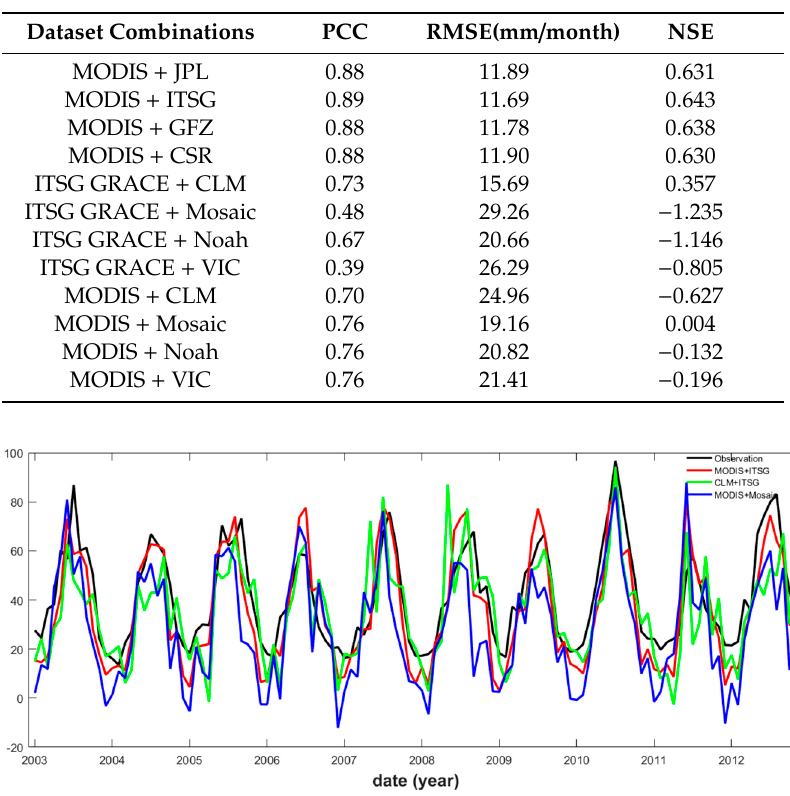
Figure 7. Remotely sensed runoff for the Yangtze river basin derived from the MODIS Figure7. Remotelysensedruno ff fortheYangtzeriverbasinderivedfromtheMODISevapotranspiration evapotranspiration and ITSG GRACE terrestrial water storage, CLM evapotranspiration and ITSG and ITSG GRACE terrestrial water storage, CLM evapotranspiration and ITSG GRACE terrestrial water storage, and MODIS evapotranspiration and Mosaic terrestrial water storage